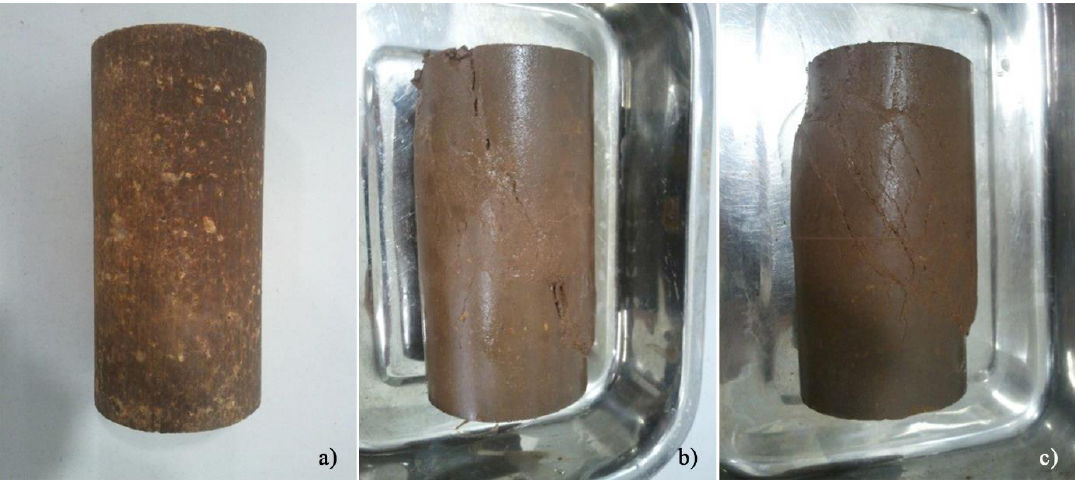
Figure 8. General condition of the AAC-S specimens: ( a ) before testing; ( b ) after testing, with 90 days curing, consolidated to 450 kPa; ( c ) after testing, with 90 days curing, consolidated to 700 kPa.